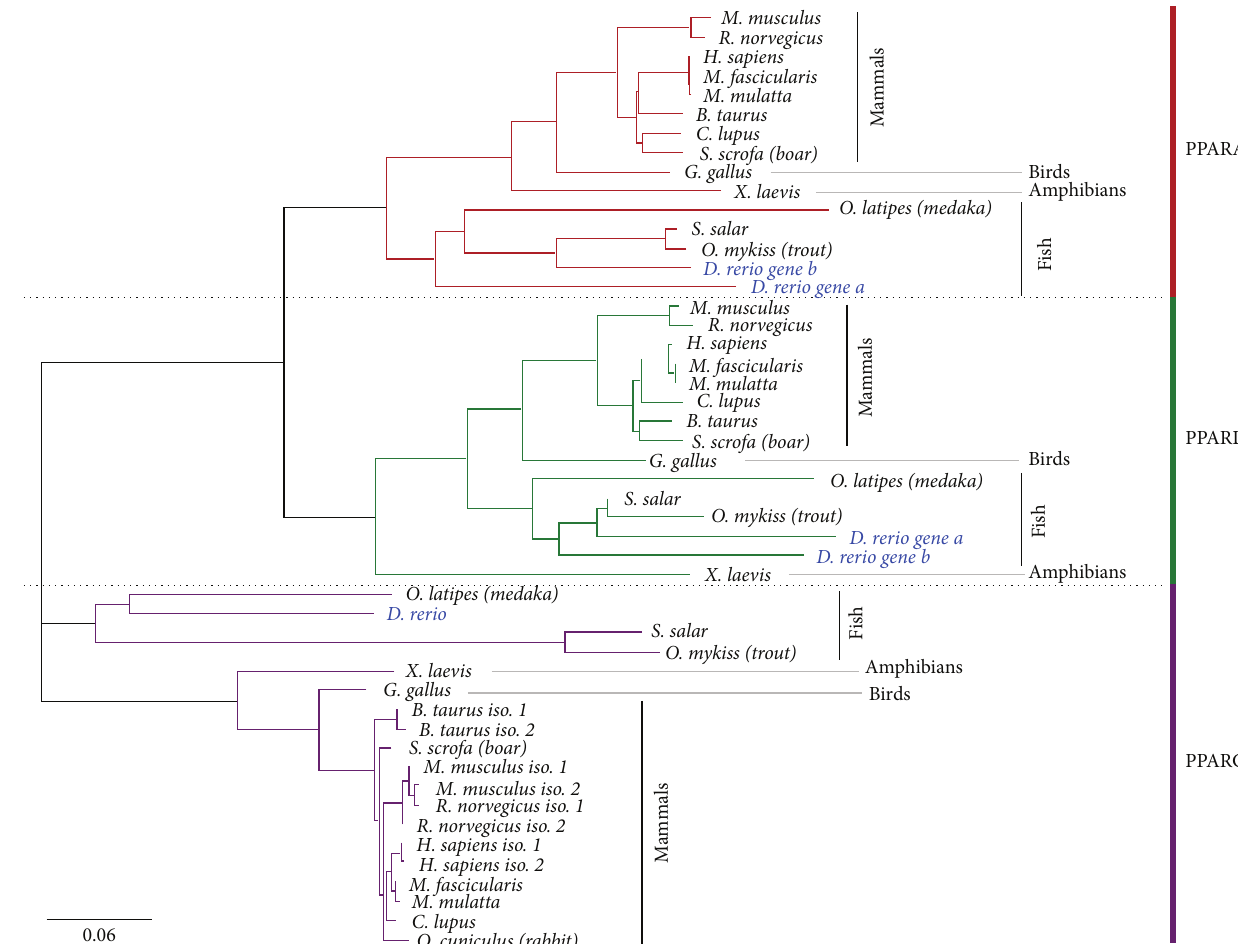
Figure 2: Phylogenetic tree of the PPAR orthologs in various organisms based on amino acid sequence difference (BLOSUM62 matrix). The phylogenetic tree is generated using the Geneious 9.0 software. Protein accession numbers information is provided in Supplemental Data 1.